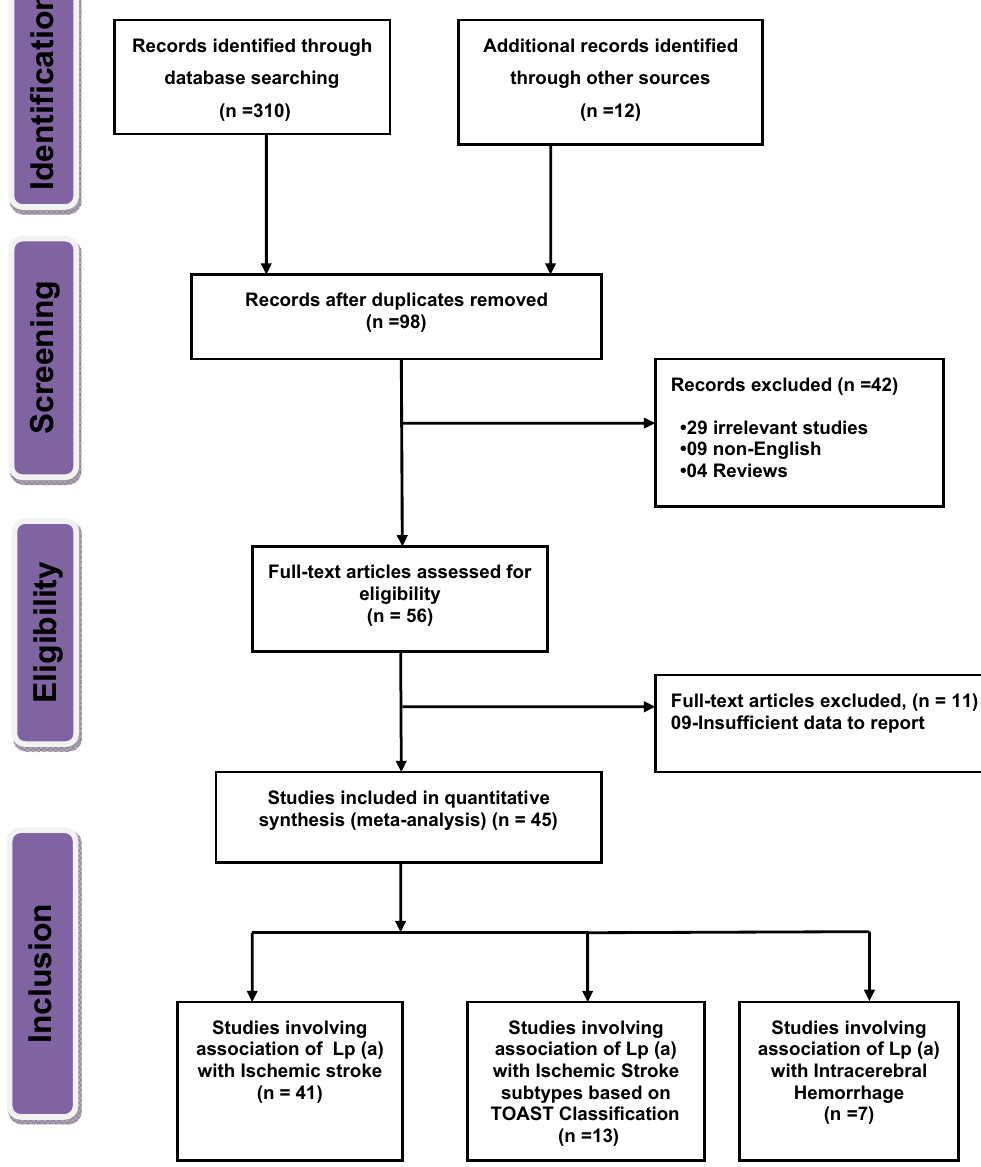
Figure 1. Flow diagram for the selection of studies and specific reasons for exclusion from the present meta-